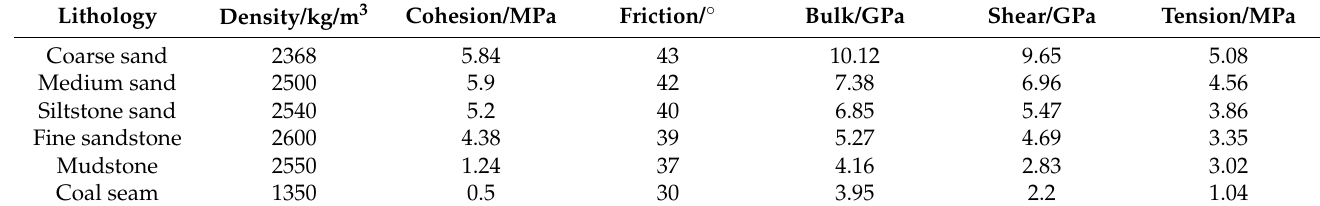
Table 2. Mechanical parameters of coal and rock mass.